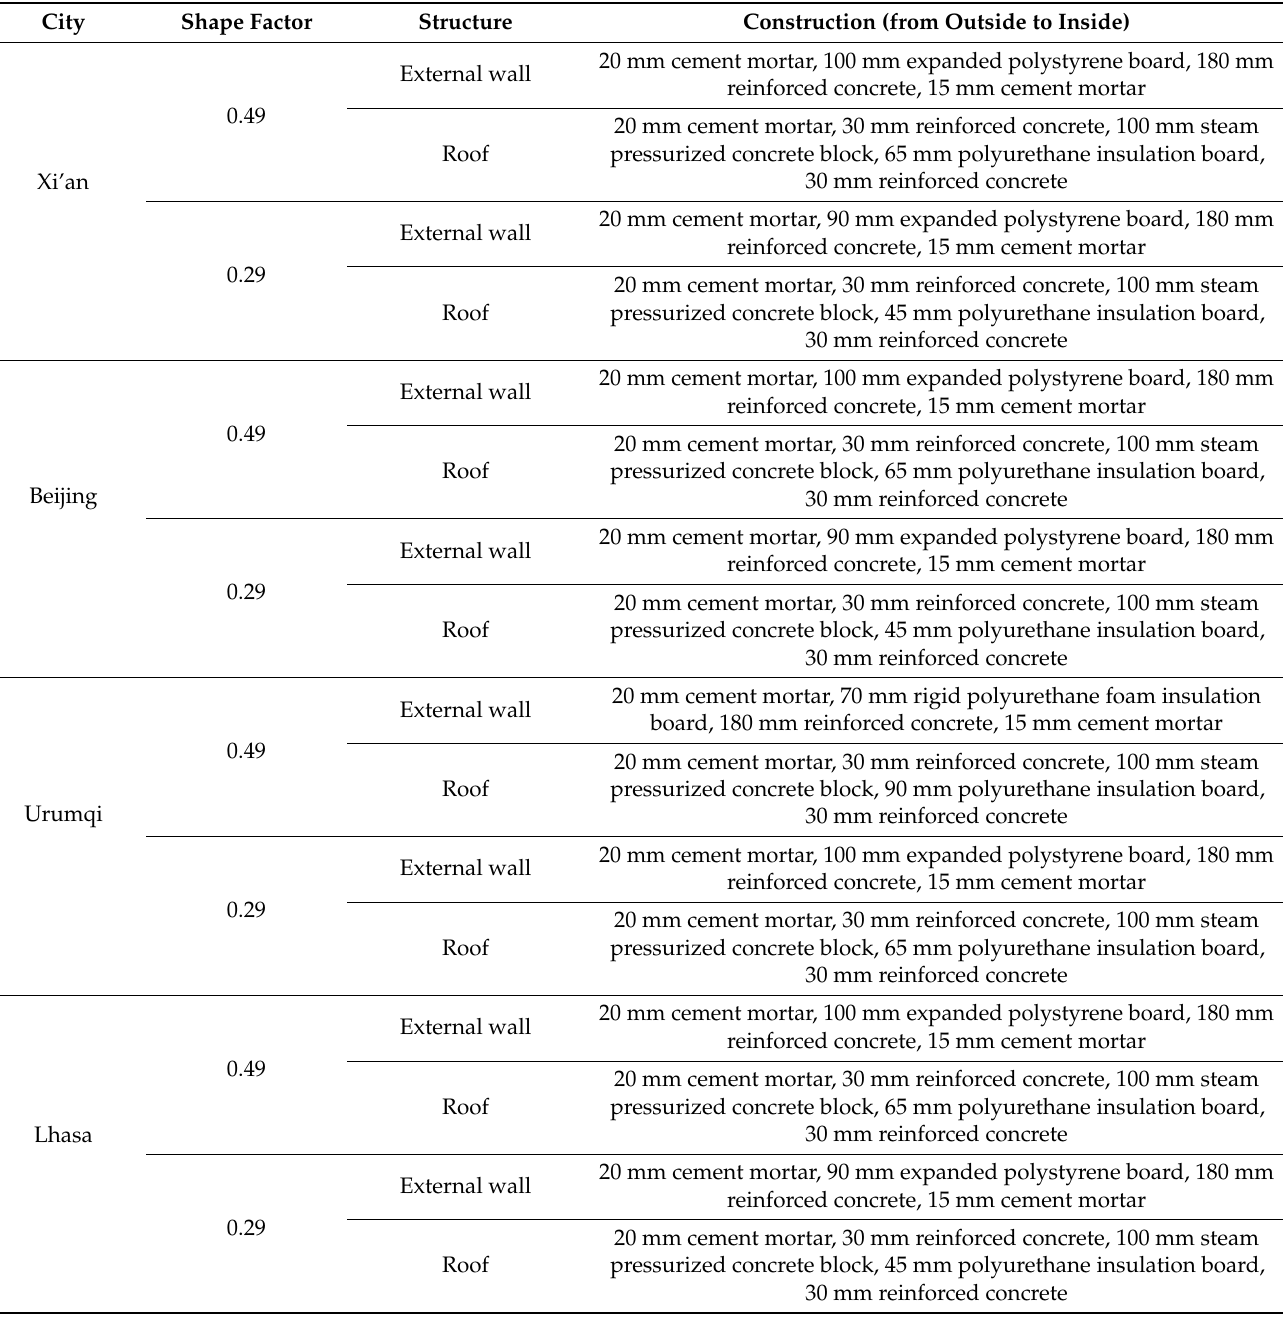
Table 2. Details of the building